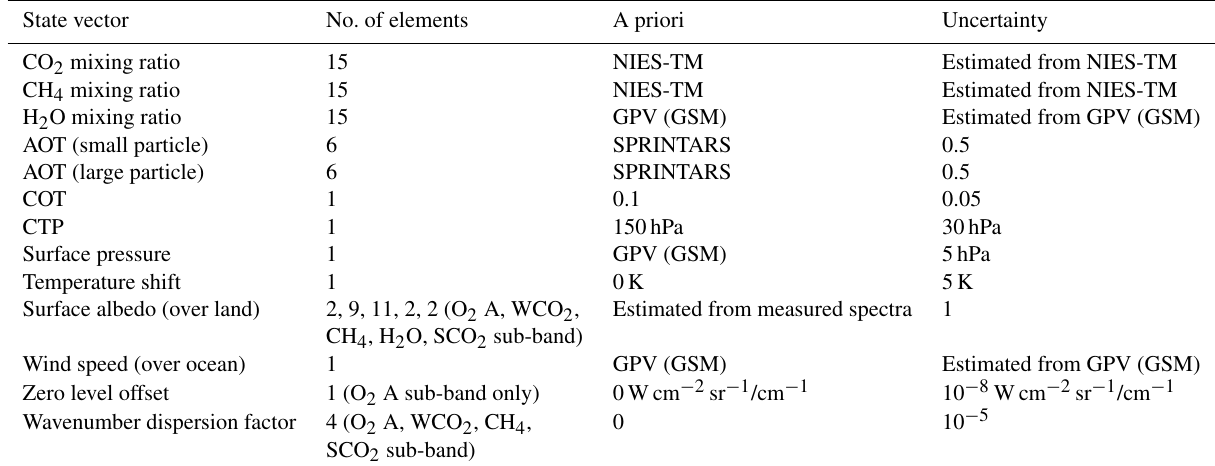
Table 2. Retrieval setup for the V03 product. COT and CTP are additional parameters from V02. State